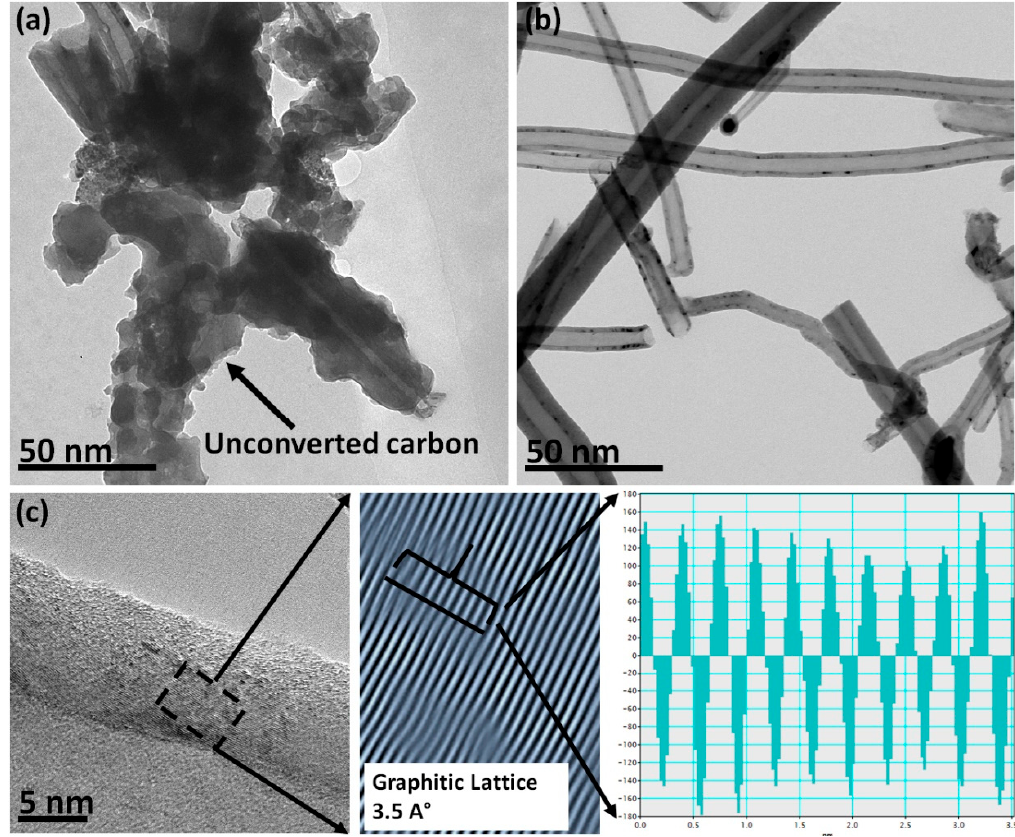
Figure 3. Transmission electron microscopy (TEM) images: ( a ) before treatment, ( b ) after treatment with H 2 O 2 and acetone, and ( c ) high-resolution images with graphite inner plans (lattices masked by Gatan Software 3.0).